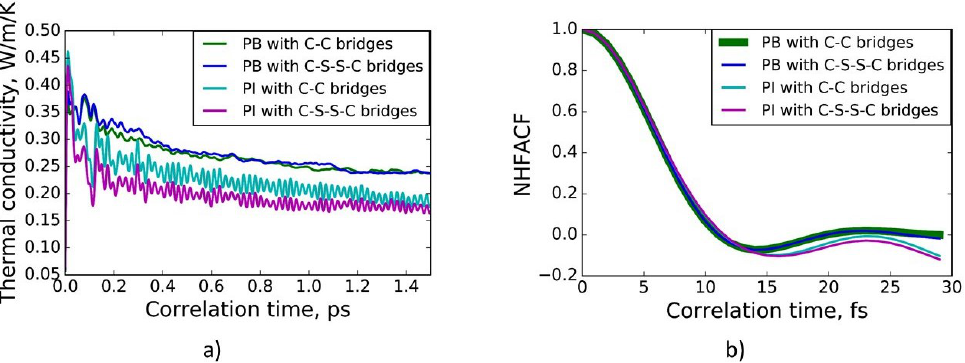
Figure 2. ( a ) Thermal conductivities of polybutadiene crosslinked by C-C bridges (green line) and by C-S-S-C bridges (blue line) and polyisoprene vulcanized by C-C bridges (cyan line) and by C-S-S-C bridges (magenta line) at normal conditions as a function of correlation time; ( b ) the first minima of the normalized heat flux autocorrelation functions (NHFACFs) of polybutadiene crosslinked by C-C bridges (green line) and by C-S-S-C bridges (blue line) and polyisoprene vulcanized by C-C bridges (cyan line) and by C-S-S-C bridges (magenta line) at normal